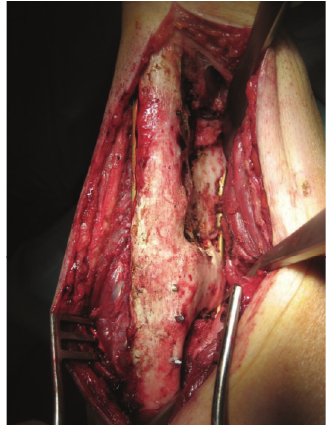
Figure 1: Right forearm in a 39-year-old man with a radioulnar synostosis type 2 18 months after the first surgery procedure for reduction and fixation of the fractures.